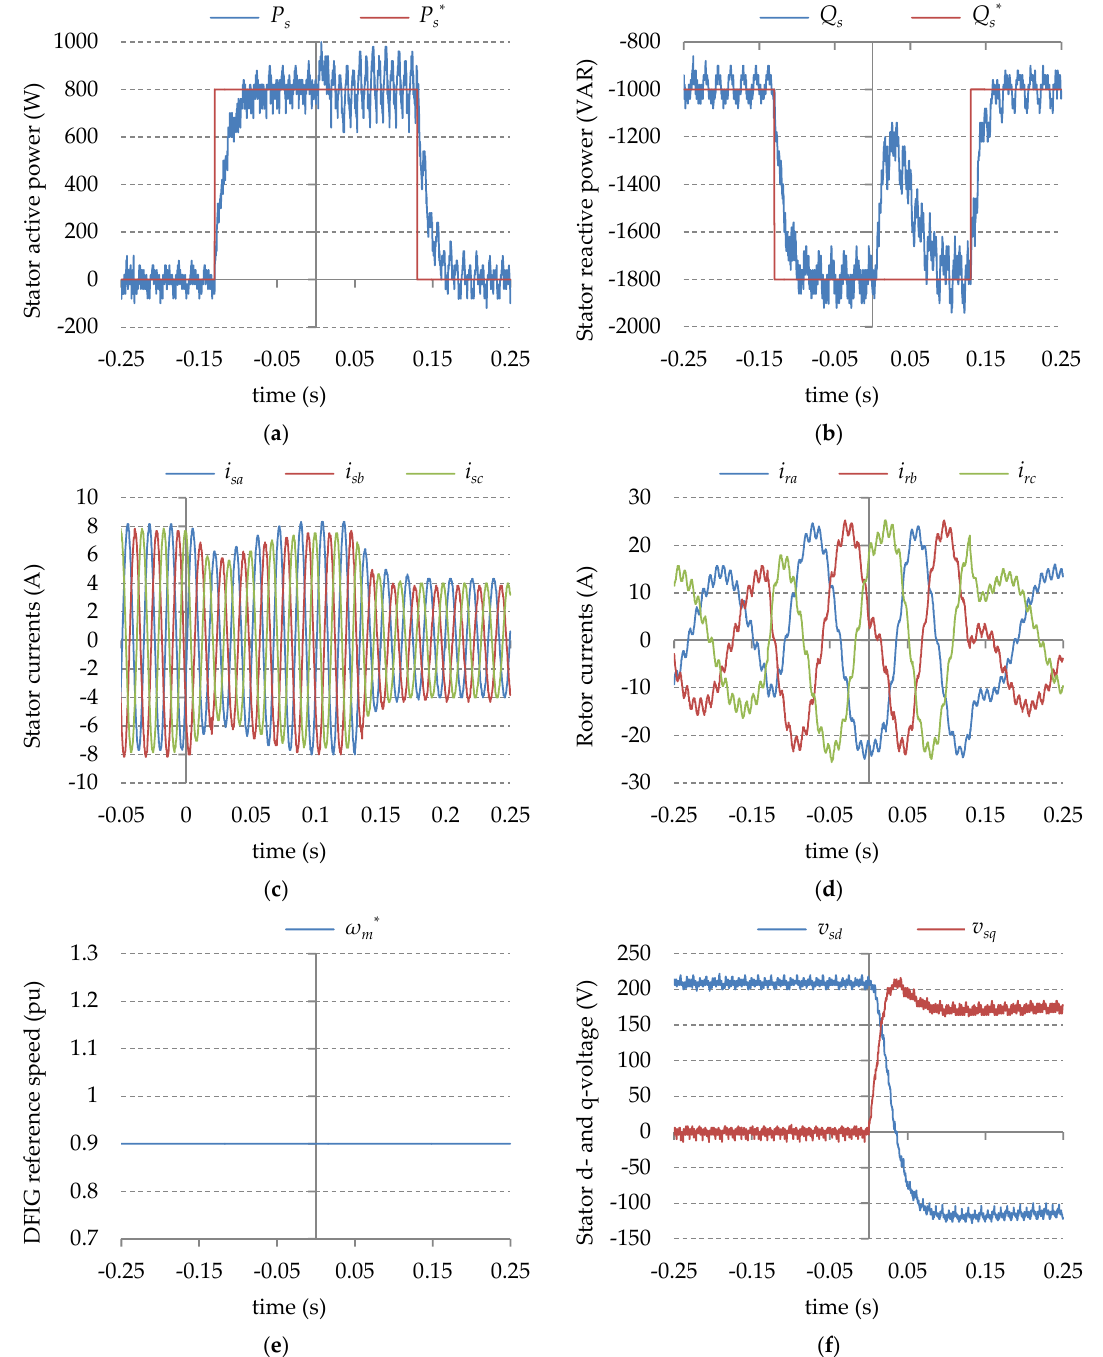
Figure 13. Experimental results for the effect of variation of the stator voltage orientation on the proposed decoupled control: ( a ) stator active power; ( b ) stator reactive power; ( c ) stator currents; ( d ) rotor currents; ( e ) DFIG’s reference speed; ( f ) stator (grid) d ‐ and q ‐ voltage.